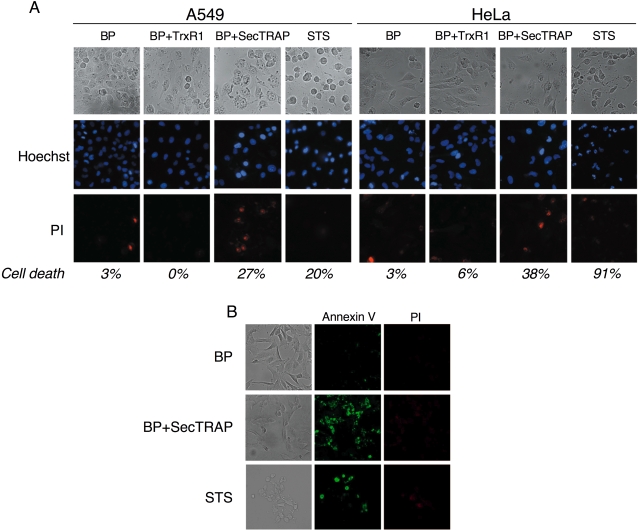
SecTRAPs induce cell death and phosphatidyl serine exposure in human cancer cells.(A) Morphological features and staining of HeLa and A549 cells after incubation for 4 h with BioPORTER (BP) alone, 100 ng full-length TrxR1/BioPORTER-complex, 100 ng SecTRAP/BioPORTER-complex or 1 µM staurosporine (STS), as indicated. Hoechst 33342 was used to visualize the shape or condensation of the nuclei and PI was used as a probe for lack of membrane integrity. Assessment of cell death was performed as described in the text. The percentage of cells denoted as dead, counting a total of 700–1000 cells in this particular experiment, is also given in italics in the lower part of the figure. (B) Exposure of phospatidylserine was evaluated after 3 h treatment of HeLa cells with either only BioPORTER, SecTRAP/BioPORTER-complex or 1 µM staurosporine, staining cells with Annexin-V and PI as described in the text. Magnification was x 40 in all panels.